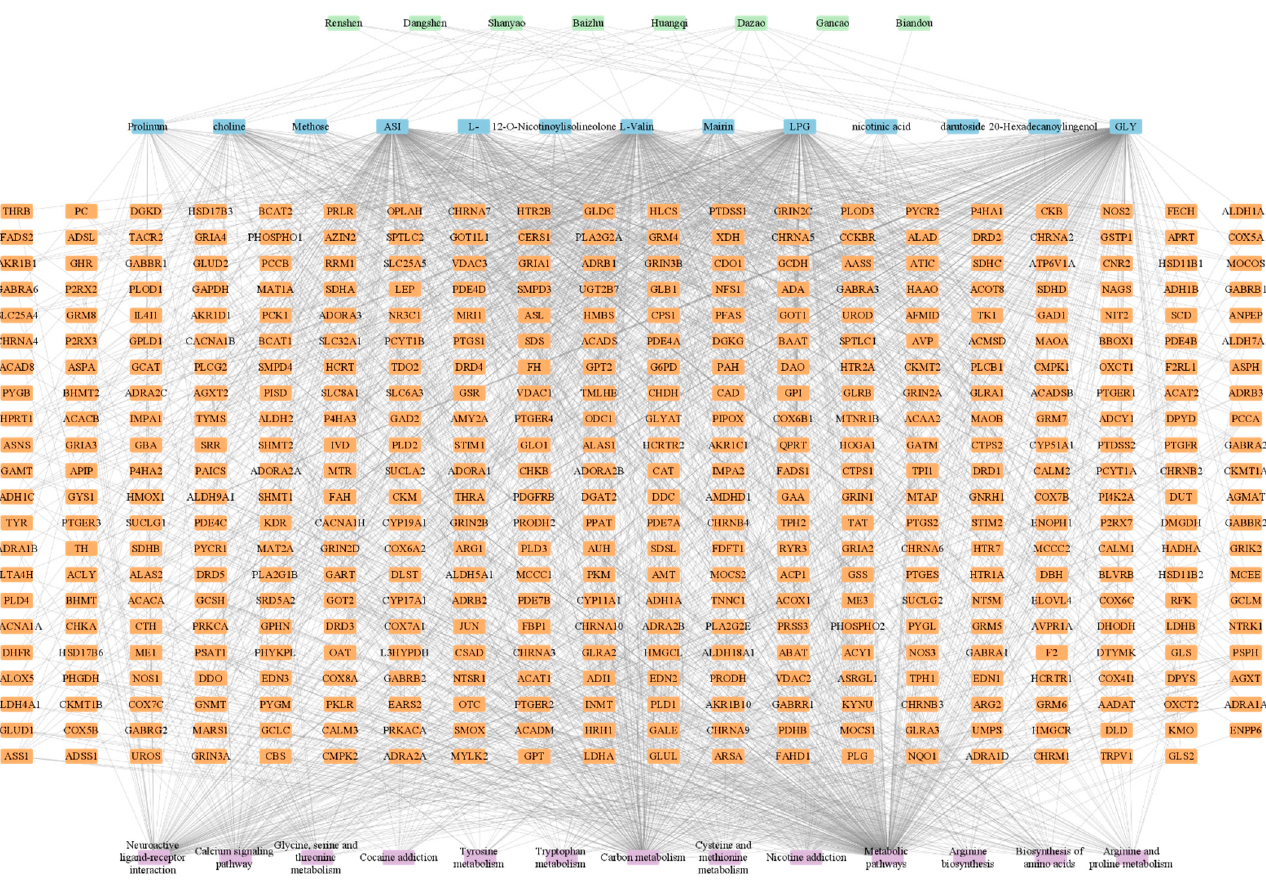
Figure 5. The herb-unique compound-target-pathway network. LPG, L-alanine; GLY, glycine; ASI, aspartic acid; L-, L-arginine.